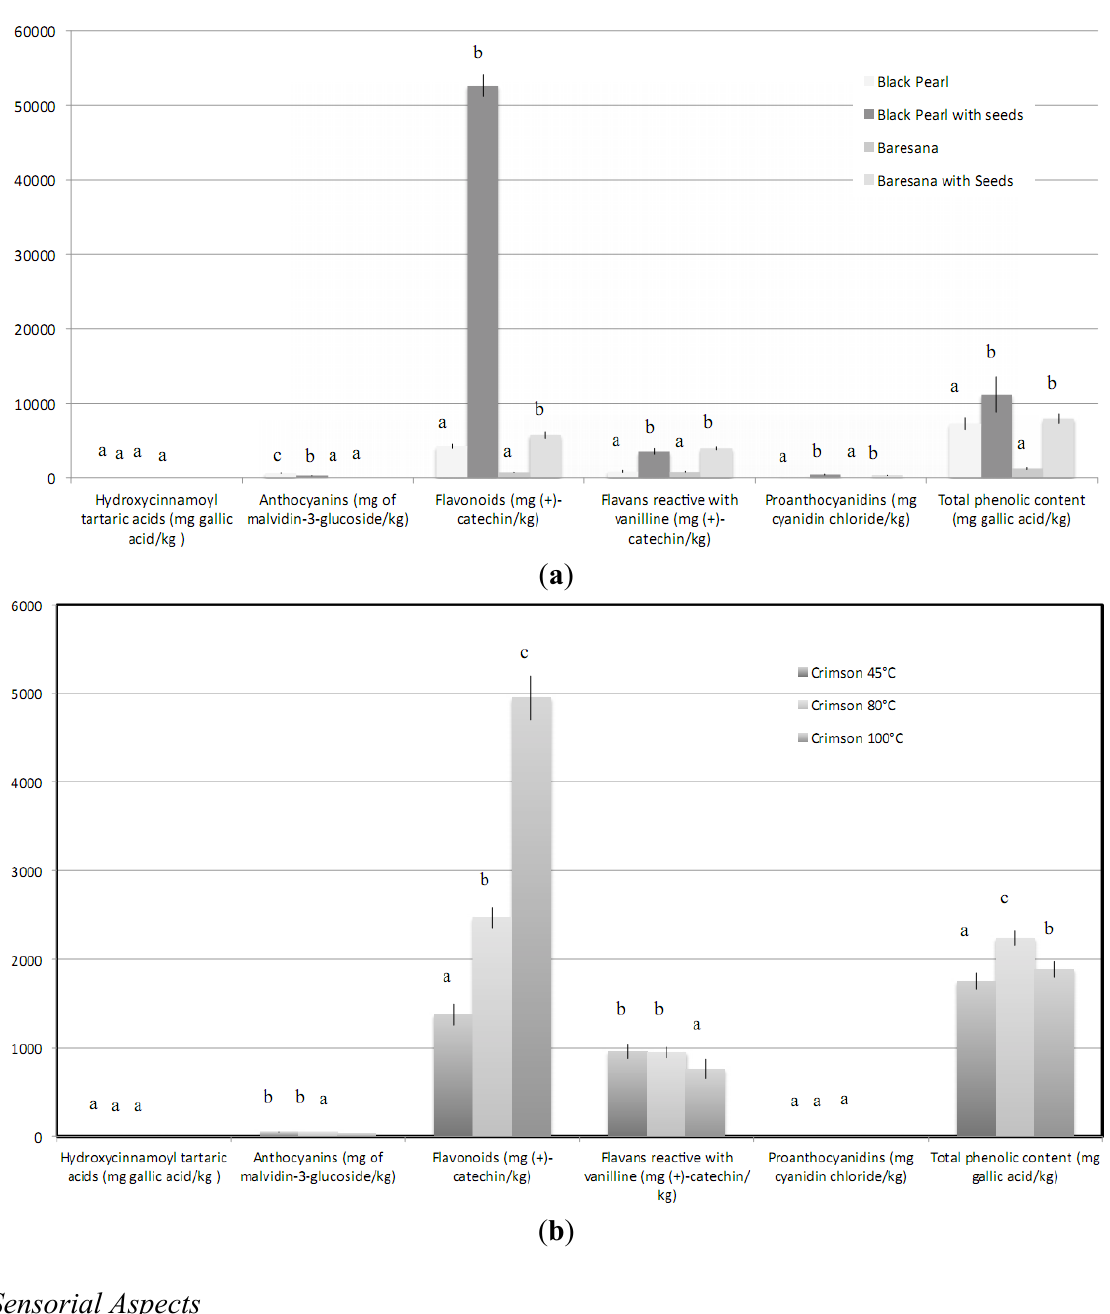
Figure 1. Phenolic composition of ( a ) Black Pearl and Baresana ( b ) Crimson grape-based smoothies. The results are expressed on a dry matter basis. Within each cultivar, different letters indicate significant differences at p <